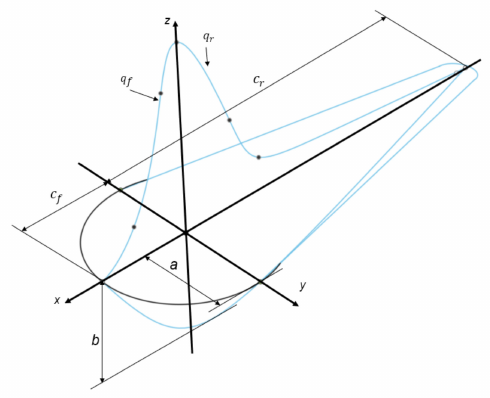
Figure 1. Scheme of the volumetric laser heat source.